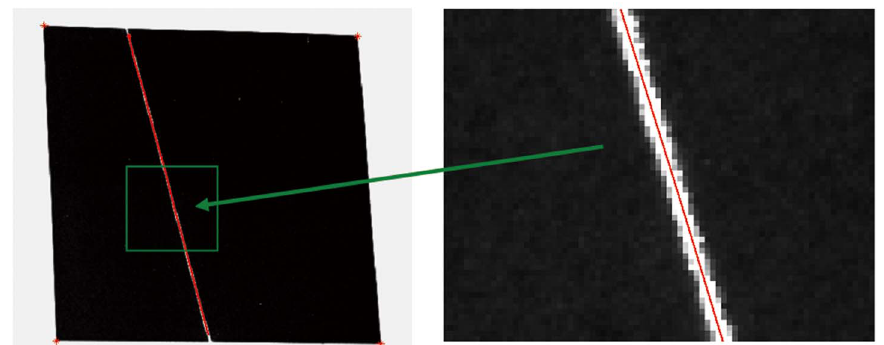
Figure 9. Detection of light stripe center.